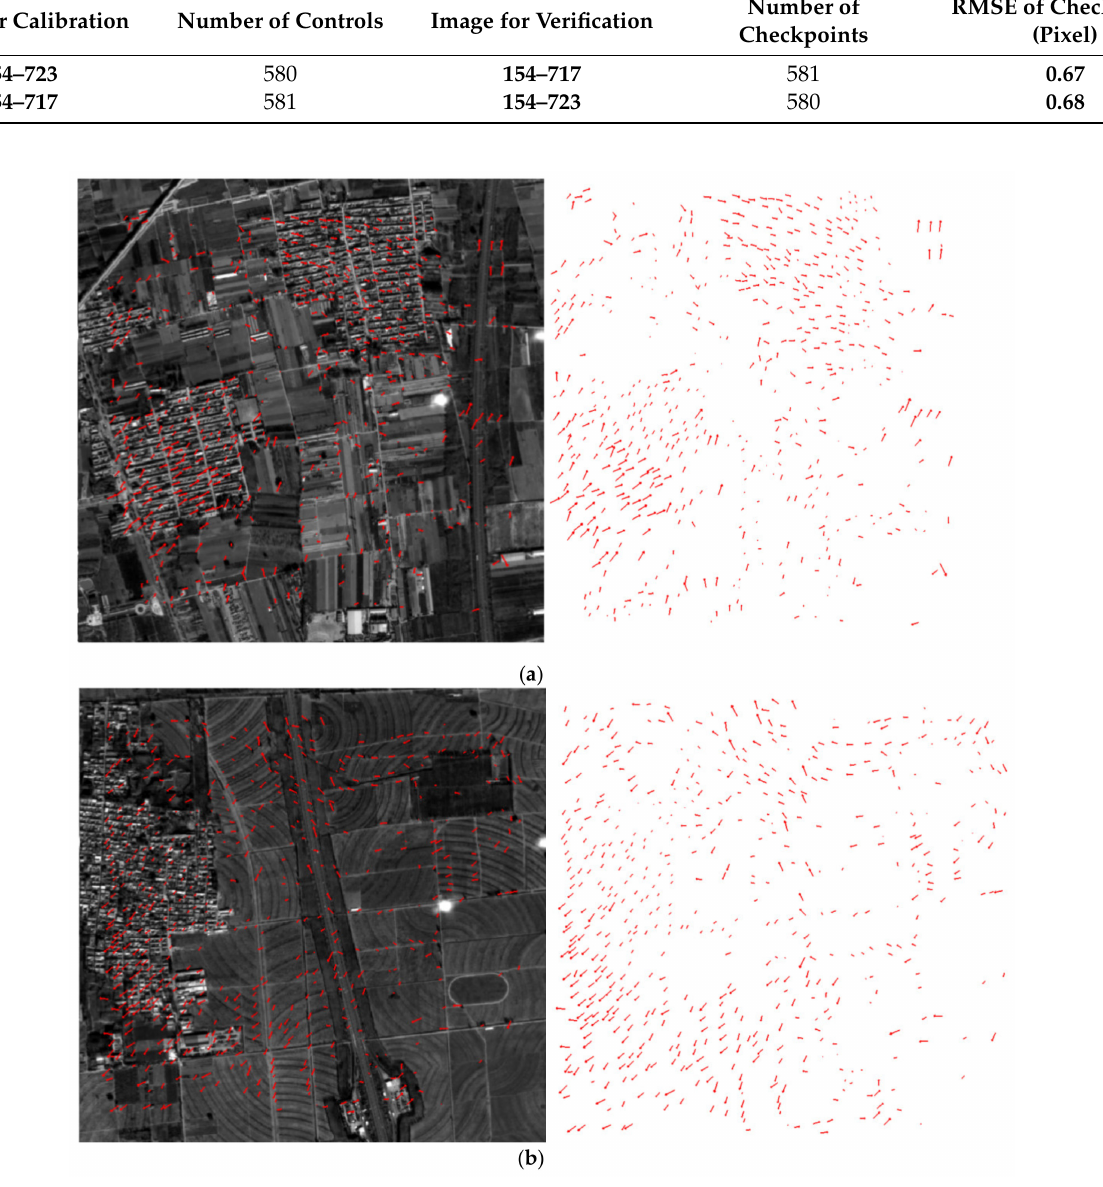
Figure 12. Verification results based on dense matches (10 × magnification). ( a ) Residual distributions of 581 checkpoints on image 717 (RMSE: 0.67 pixel). ( b ) Residual distributions of 580 checkpoints on image 723 (RMSE: 0.68